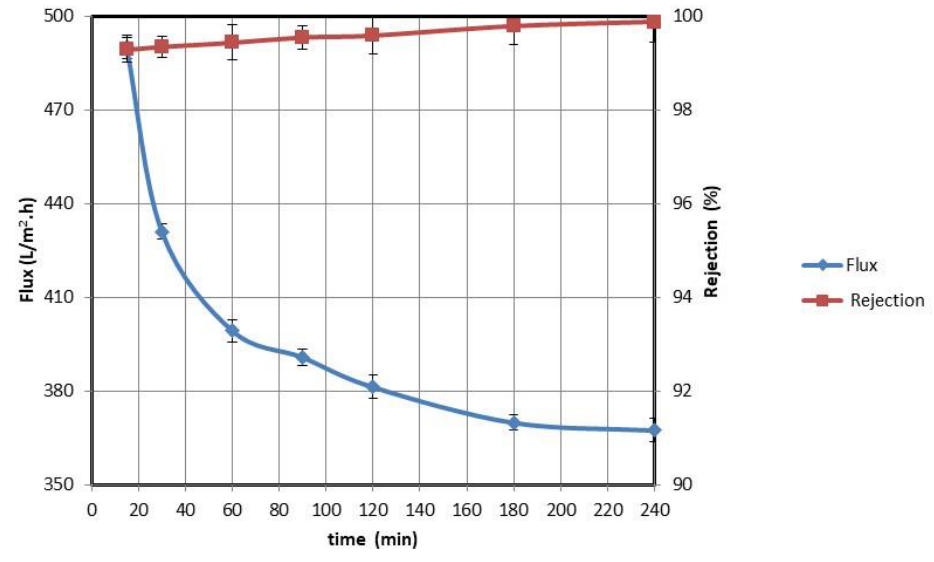
Figure 9. Water/synthetic oil flux rate through membrane and percentage rejection by a fabricated membrane at different times.